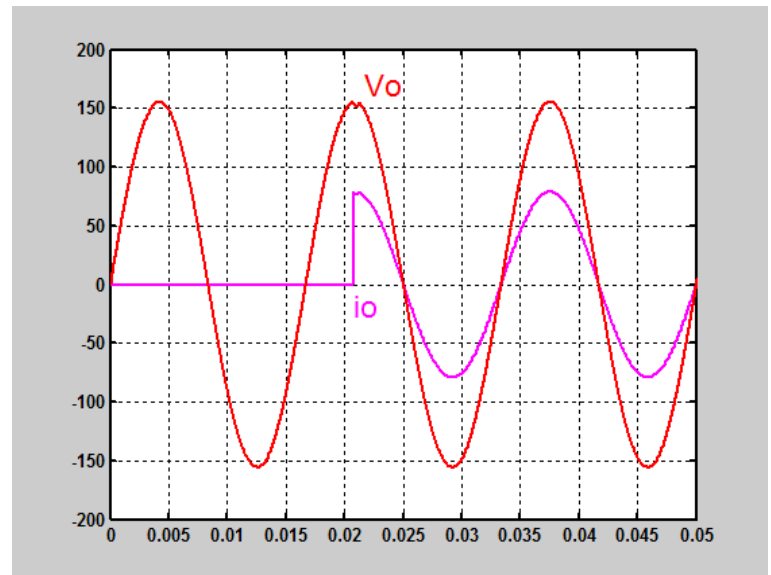
Figure 4. Simulated waveforms in response to the load suddenly turn on for the modified control technology (50 V/div; 10 A/div).